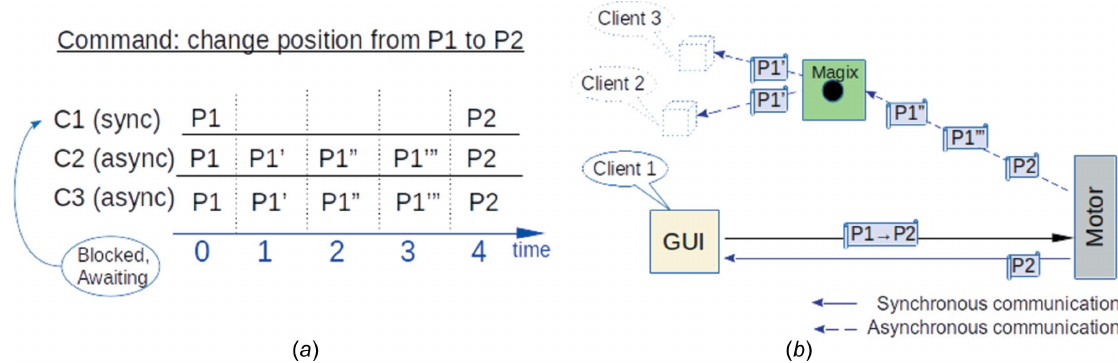
Figure 1 An example of the difference between synchronous and asynchronous communication. Client 1 (GUI) sends a message with a command to change the state of the motor from the current P1 position to P2 at the t0 time. After receiving the message, the motor begins to execute the command and changes its states. The motor moves through intermediate positions P1 0 , P1 00 , P1 000 to reach the P2 position. Via synchronous communication the Client 1 (GUI) receives response P2 at the t4 time. Whereas via asynchronous communication Client 2, Client 3 (these may be another GUI, other motors or systems), which want to receive information about intermediate motor’s states, receive these intermediate positions simultaneously: P1 0 at t1 time, P1 00 at t2, P1 000 at t3 and P2 at t4